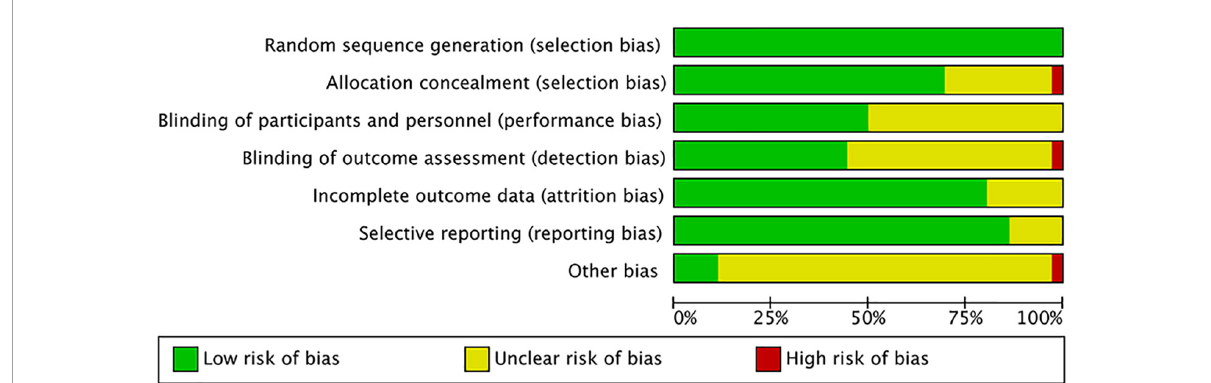
FIGURE4 Risk of bias summary.